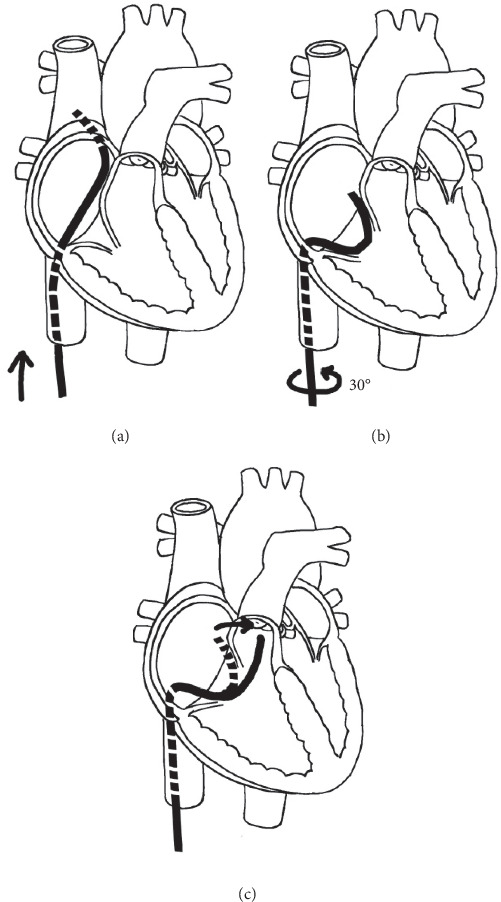
(a) The Simmons catheter is advanced to the right atrium directly. (b) The catheter is rotated counterclockwise about 30°. (c) When the distal part of the Simmons catheter points to the left, it will flip into the RVOT.